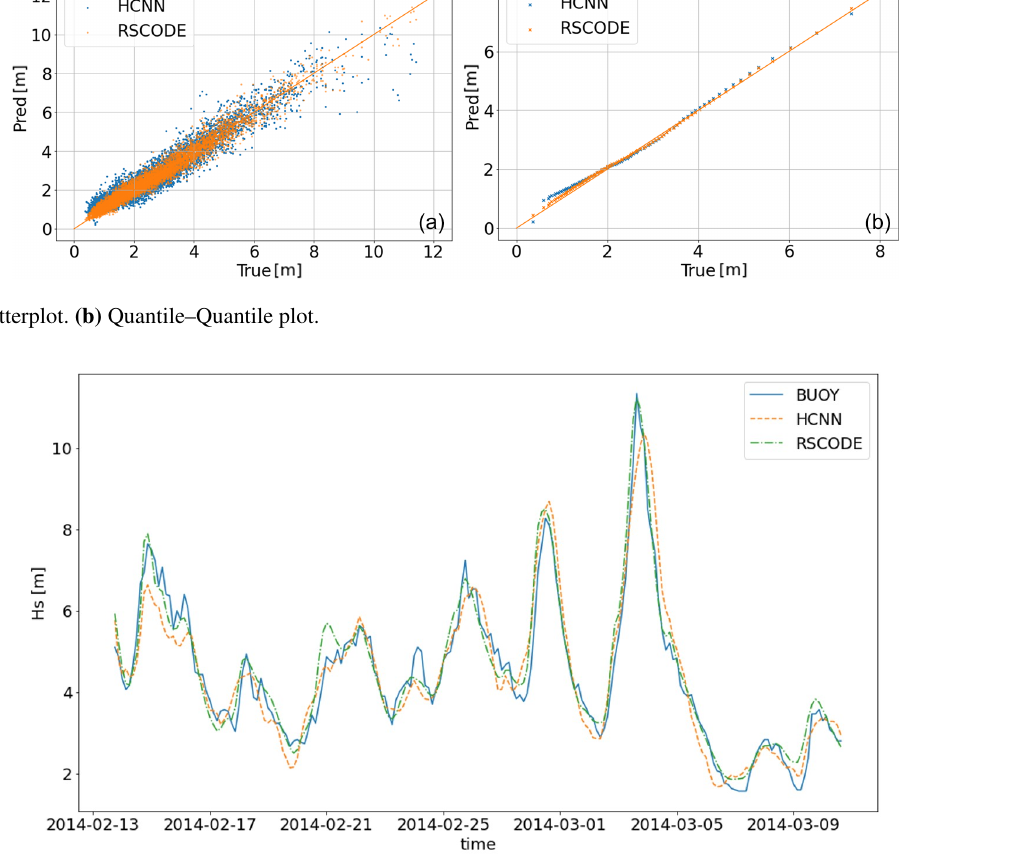
Figure 11. A 3h time series of H s from the buoy (blue; solid line), HCNN (orange; dashed line), and RSCODE (green; dash-dotted line) at station no. 62001 over 1 month of the validation